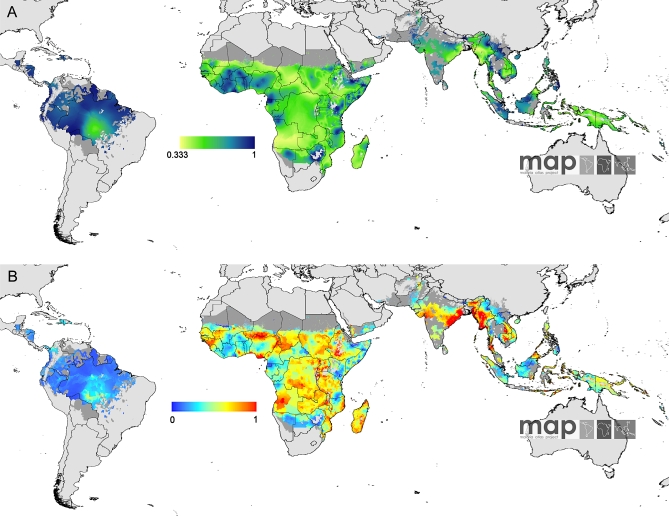
Maps of Model Uncertainty(A) The probability of PfPR2−10 being in the class to which it was assigned is mapped and shown as a yellow to blue continuum from 0.3̇ − 1. Any value above 0.3̇ is better than a chance allocation. The rest of the land area was defined as unstable risk (medium grey areas, where PfAPI < 0.1 per 1,000 pa) or no risk (light grey) [17–19].(B) The population-weighted index of uncertainty. This index shows the likely importance of uncertainty assessed by the product of the log of population density (Protocol S2.3) and the reciprocal of the probability of correct class assignment, rescaled from 0–1. The index is shown for the most probable PfPR2−10 endemicity class. Unstable and no risk are as (A).